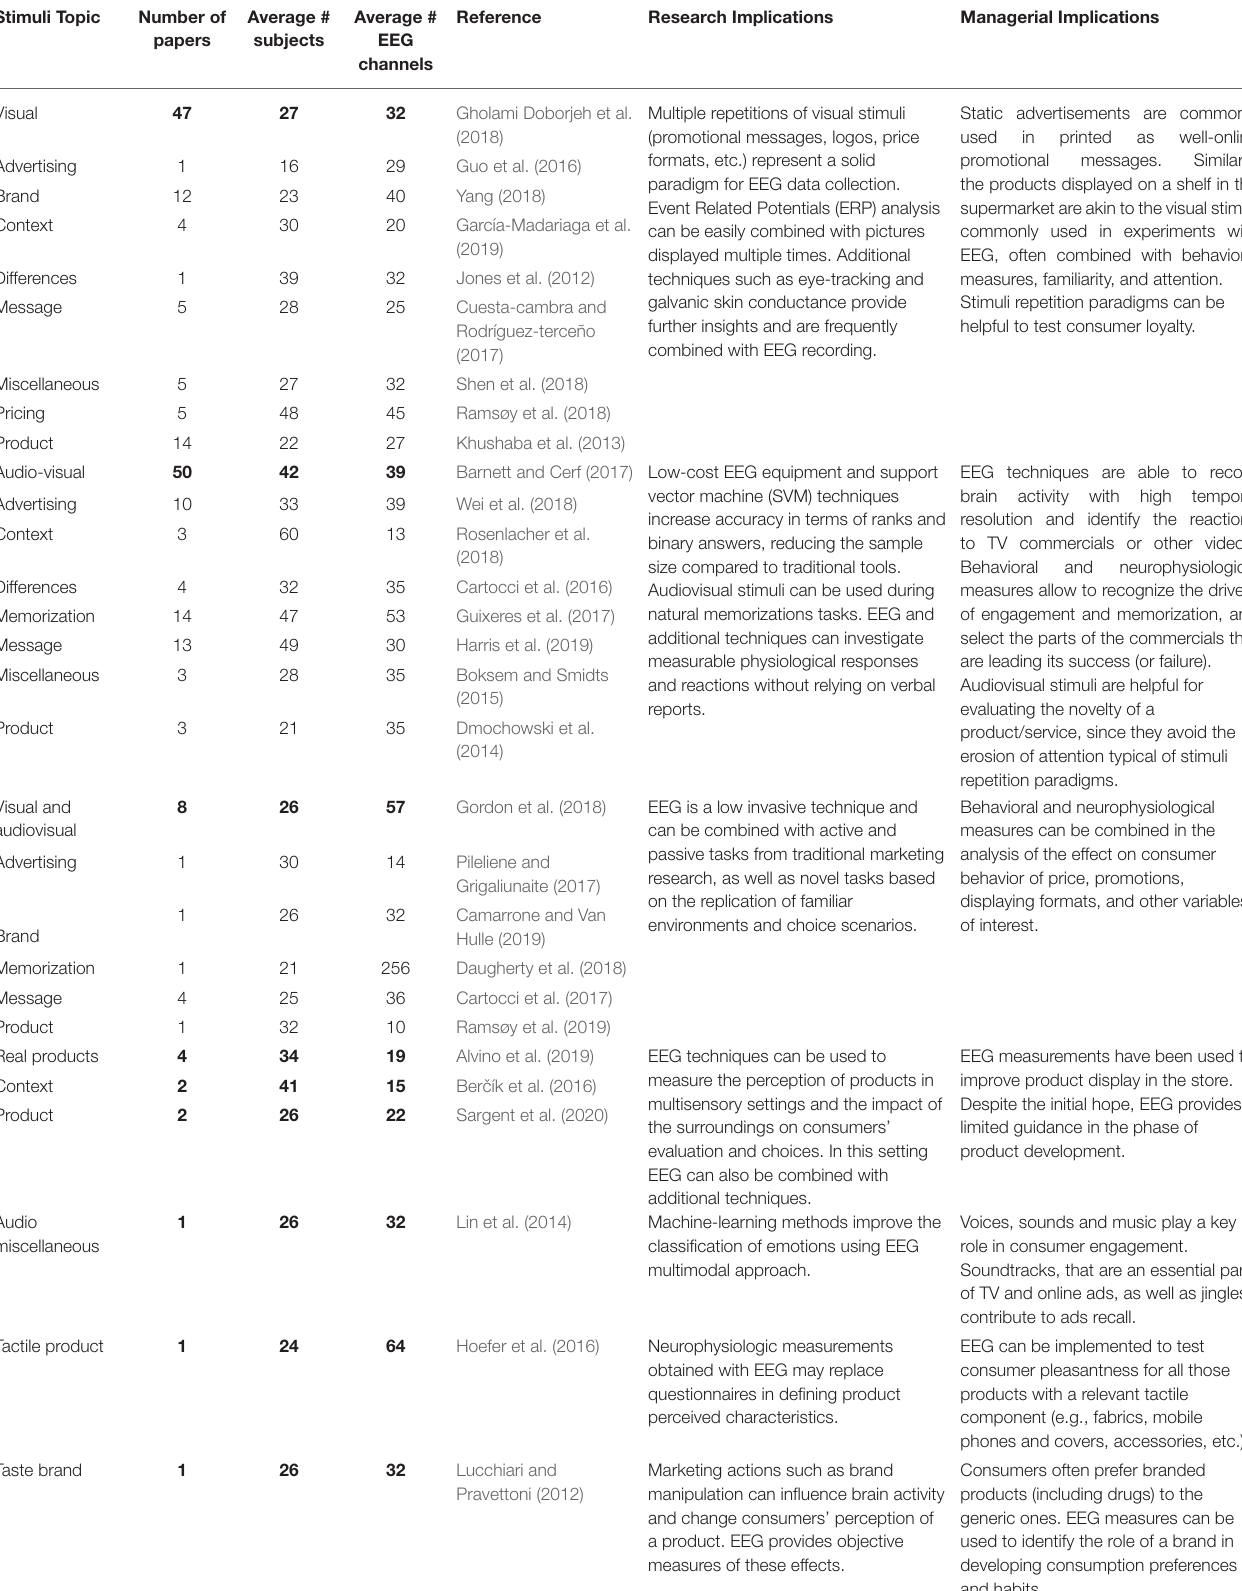
TABLE 3 | Research design, frameworks, and managerial